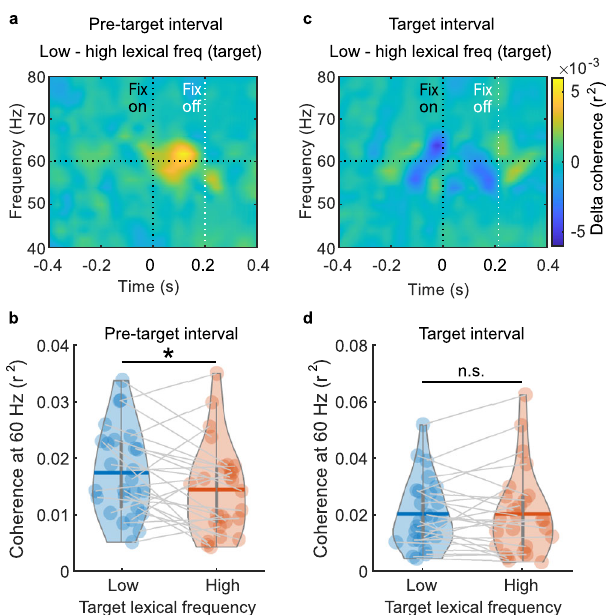
Fig. 4 Neuronal evidence for lexical parafoveal processing. a Time- resolved coherence differences during pre-target word fi xations (low minus high lexical frequency target words; n = 26) revealing a lexical parafoveal effect around 100 ms after fi xation onset. b The averaged pre-target coherence at 60 Hz during pre-target fi xations for low (blue) and high (orange) lexical frequency target words (* p = 0.037, n = 26, two-sided pairwise t -test). c , d During target word fi xations we did not observe a coherence difference with respect to lexical frequency ( p = 0.992, n = 26, two-sided pairwise t -test). Horizontal bars in the violin plots indicate mean value. Each dot presents one participant. Source data of panel b and d are provided as a Source Data fi le.